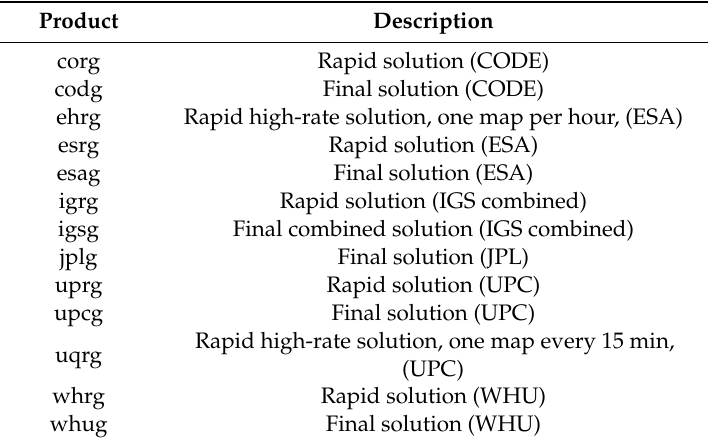
Table 1. Global ionospheric maps (GIM) products used.